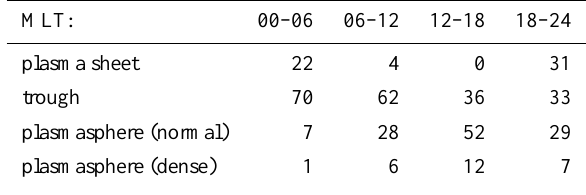
Table 1b. As Table 1a, but for K p = 1 + − 2 +